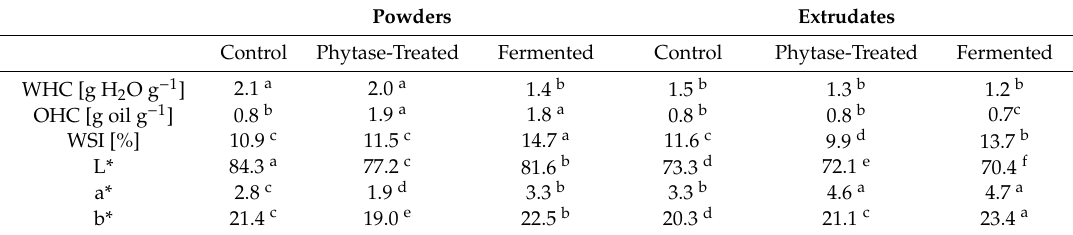
Table 4. Physicochemical properties of powders and extrudates. Values sharing a letter within a row are not statistically di ff erent. WHC: water holding capacity; OHC: oil holding capacity; WSI: water solubility index; L*, a*, b*: CIELAB color space values. Powders Extrudates Control Phytase-Treated Fermented Control Phytase-Treated Fermented WHC [g H 2 O g − 1